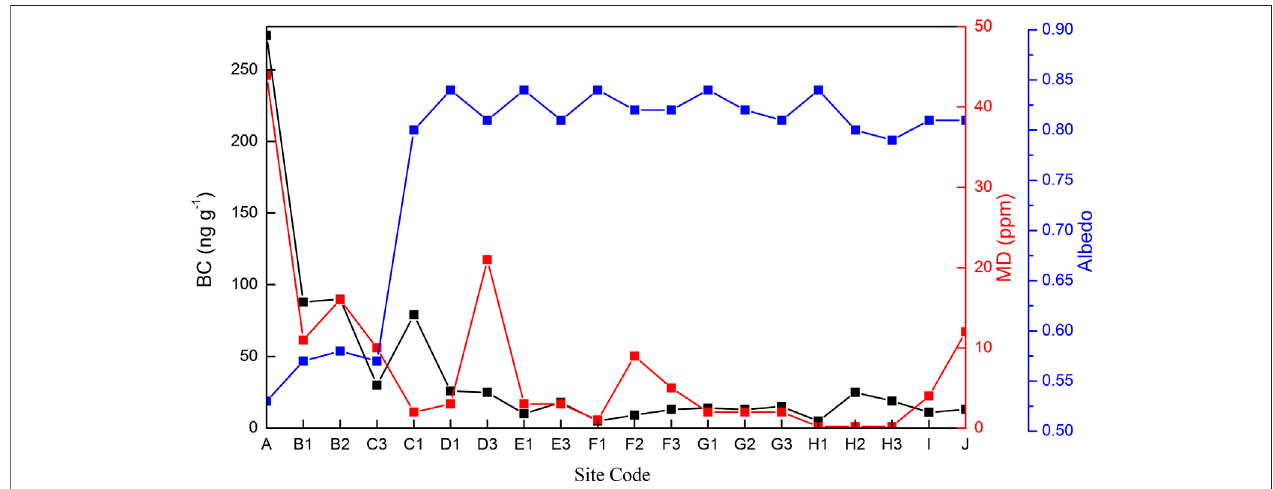
FIGURE 7 | The mean albedo ofsurface snow/ice measured by the Analytical Spectral Devices (ASD) on 12August, alongwith BC and dust concentrations at the sampling sites.